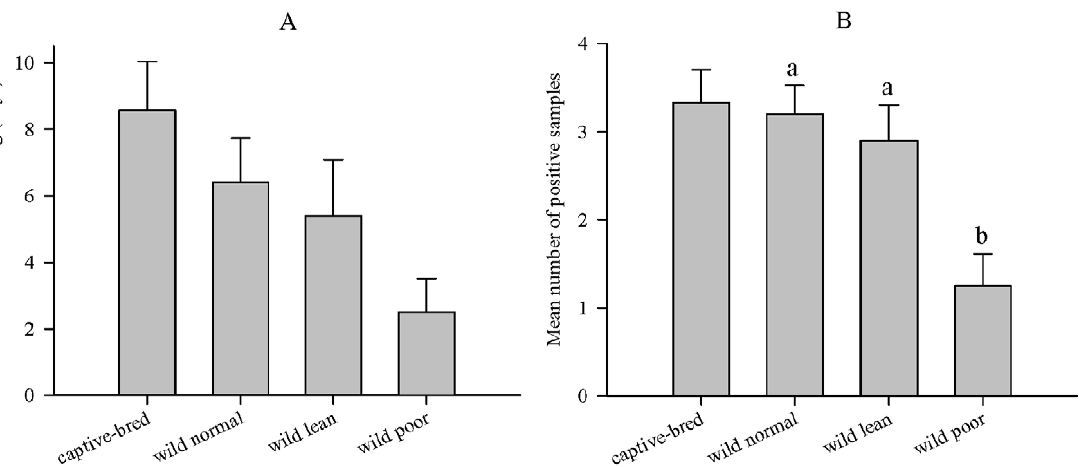
Figure 5. Duration of viral shedding (A) and mean number of positive samples (B) for captive-bred and wild mallard treatment groups. Bars represent means 6 1 standard error, letters identify significant differences among wild mallard treatment groups (Mann-Whitney rank sum, alpha=0.05). The mean number of positive samples was calculated from the 4 sampling days between 1–5 dpi.